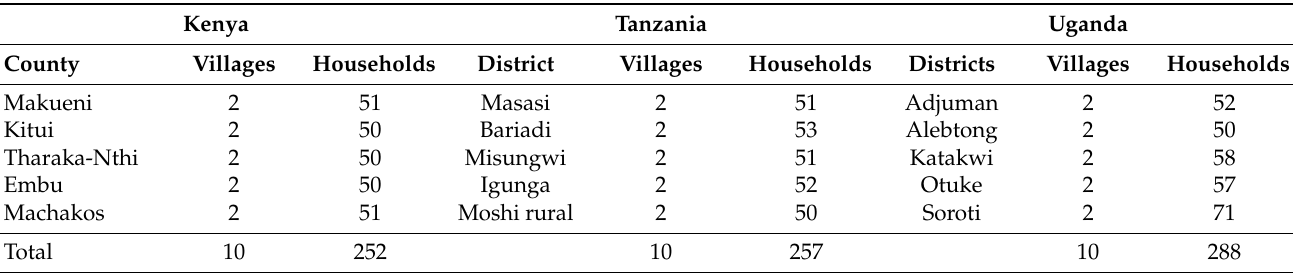
Table 1. Study countries, sample districts, villages and